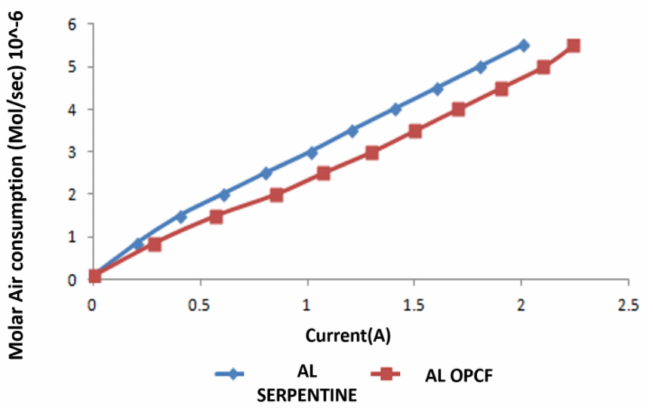
Figure 11. Air consumption (Al bipolar plate